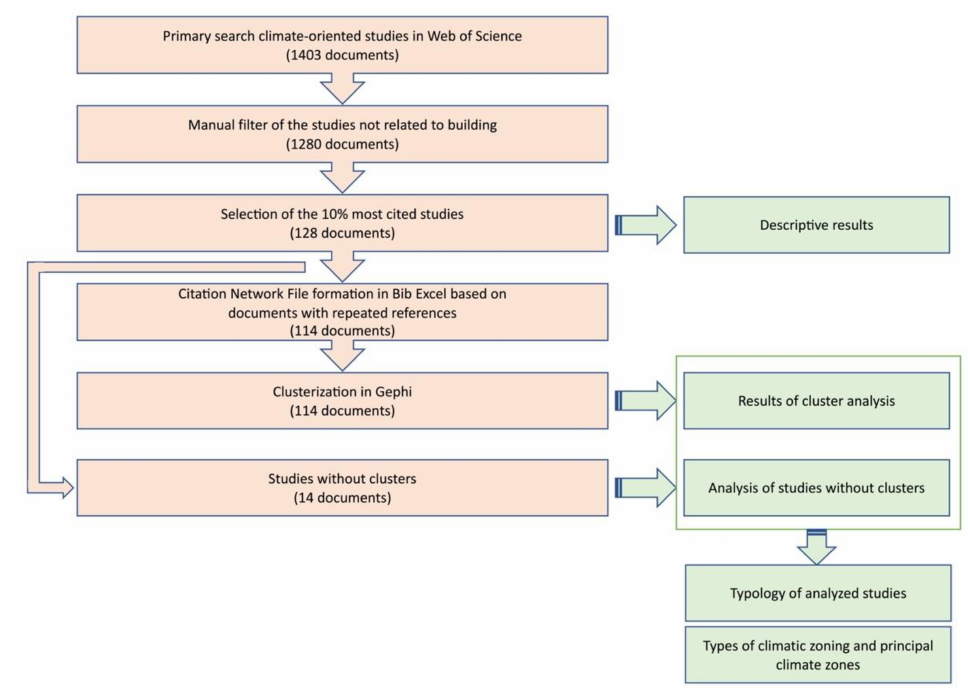
Figure 2. The general methodology of the present